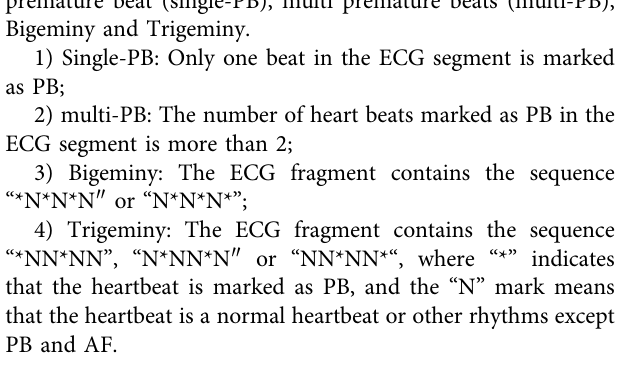
Frontiers in Physiology |